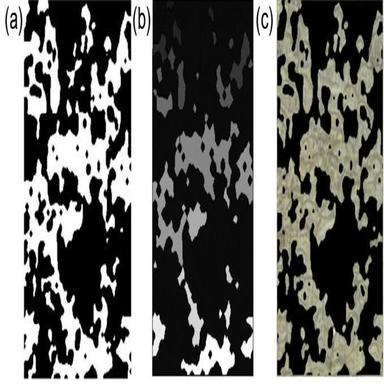
a) high gradient (underlying reinforcing element regions) detected by applying Canny windowing, (b) marker image, and (c) reinforcing elements are yielded by watershed segmentation method.